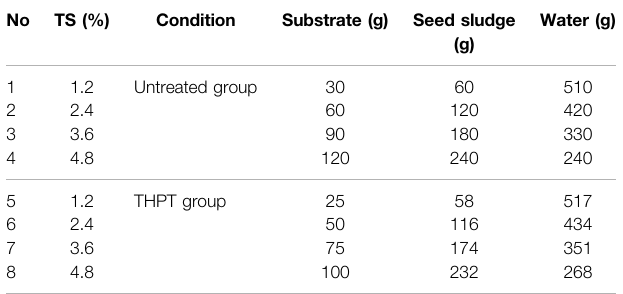
TABLE 2 | BMP test design for batch AD of tofu with different solid